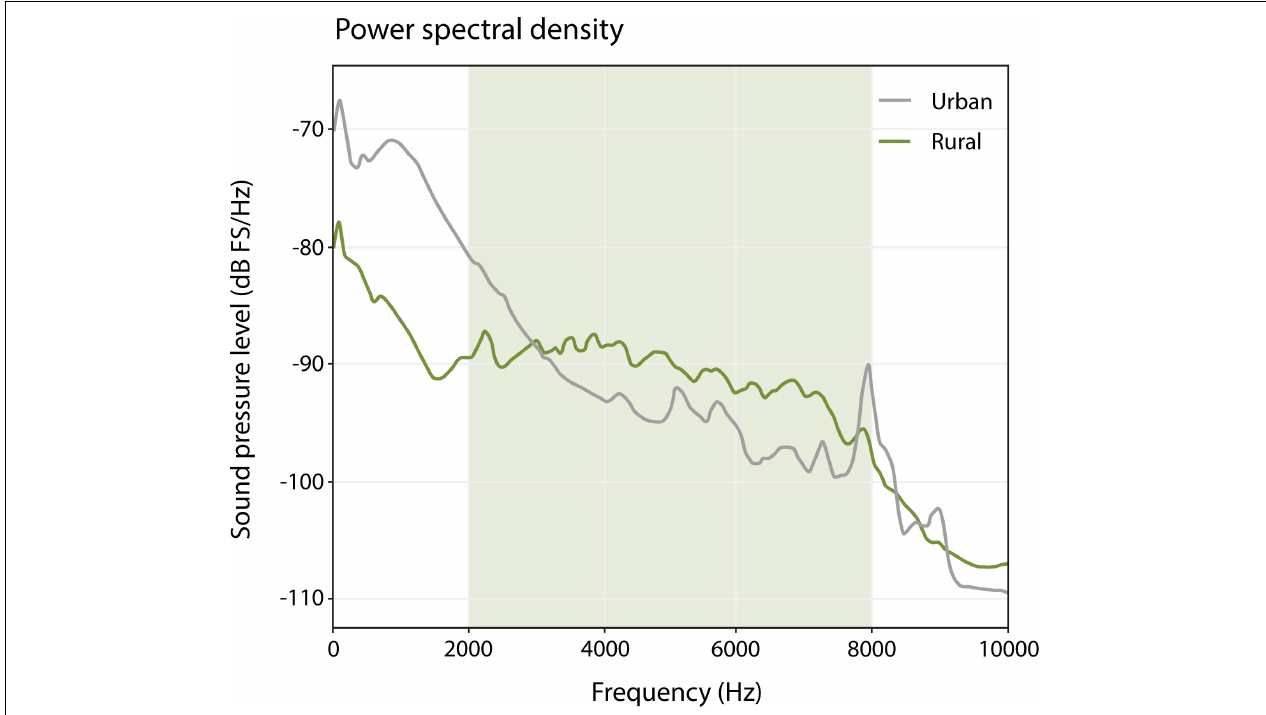
FIGURE 2 | Power spectral density plot (window length: 512, window type: Hann) of urban and rural sites, based on the average of 10 one-min samples for urban sites, and 10 one-min samples for rural sites, during the morning hour with most singing activity (5:30–6:30). The green-shaded area represents the frequency range used by great tits between 2000 and 8000 Hz. Note that below 3000 Hz, urban great tits have relatively more competition for acoustic space than rural birds, and above 3000 Hz, rural birds have a relatively more noisy